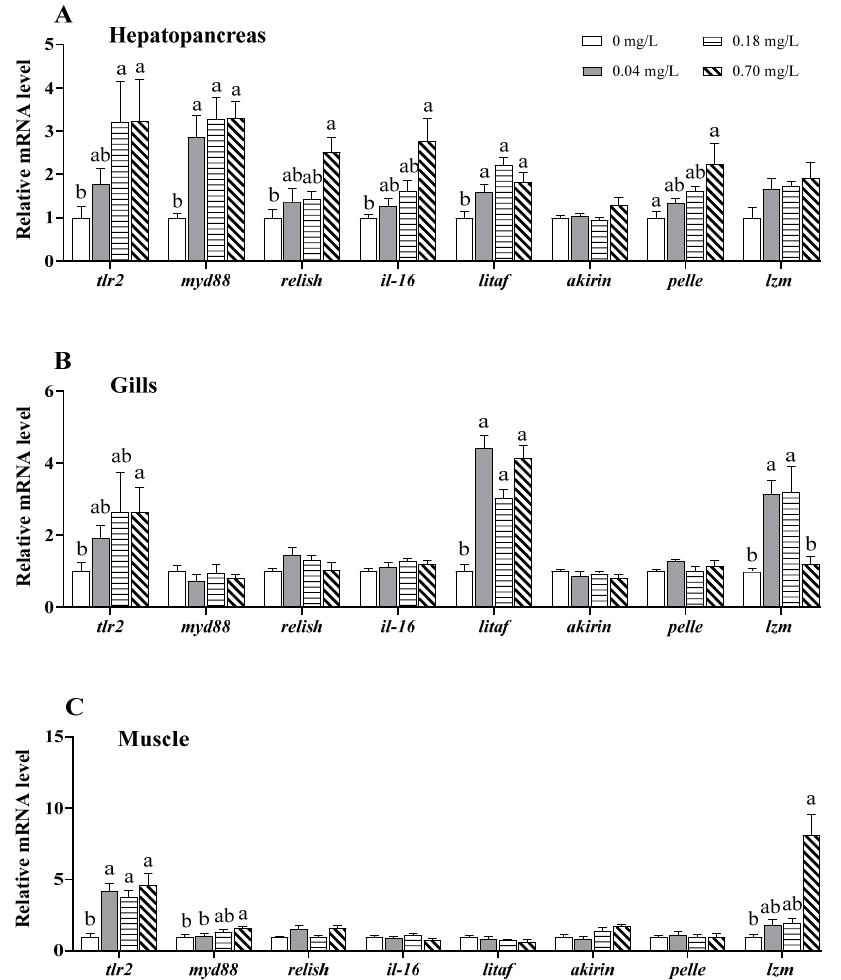
Figure 7. Expression of immune response-related genes in different tissues of E. sinensis exposed to copper for 5 days. ( A ) Hepatopancreas; ( B ) gills; ( C ) muscle. The values are expressed as the mean ± SEM ( n = 6). Different letters denote significant differences among different groups ( p <